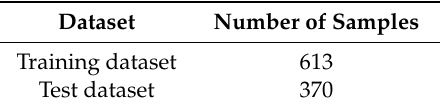
Table 1. Statistics of the Strawberry